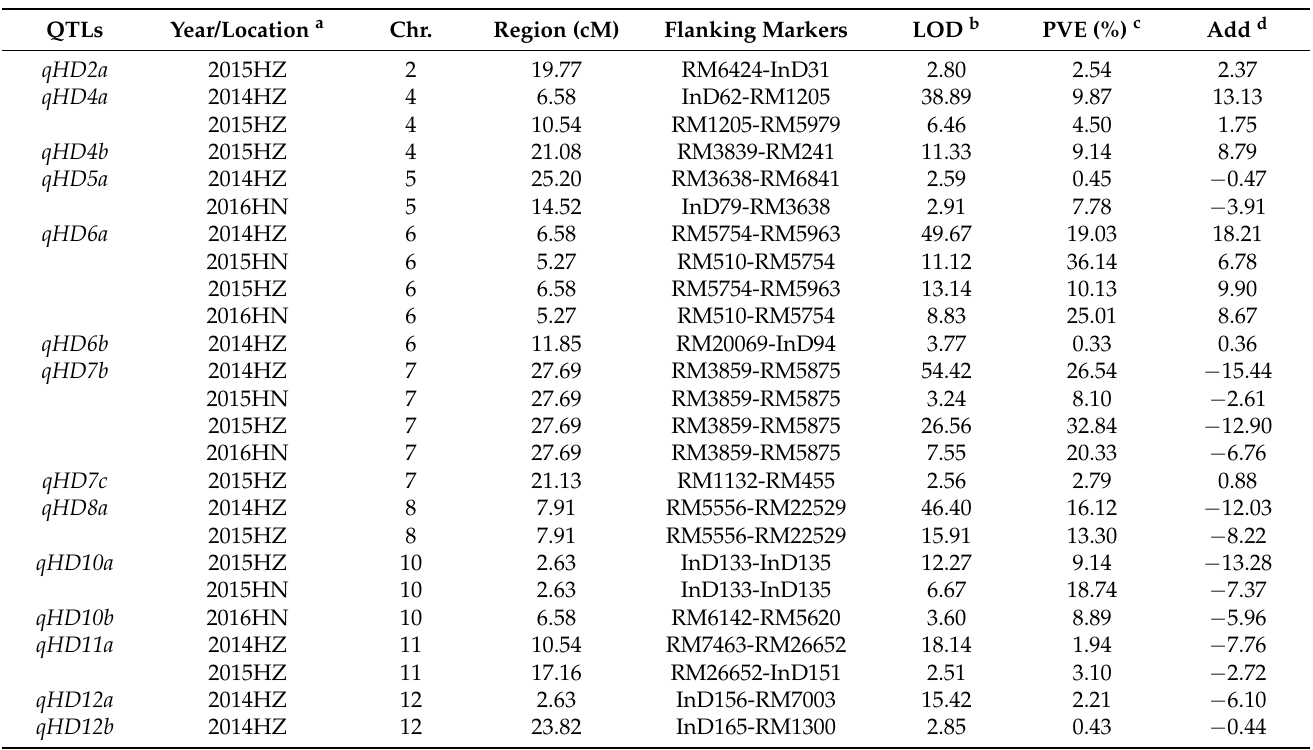
Table 2. Chromosomal locations of putative HD QTLs under four different environments using 76 CSSL